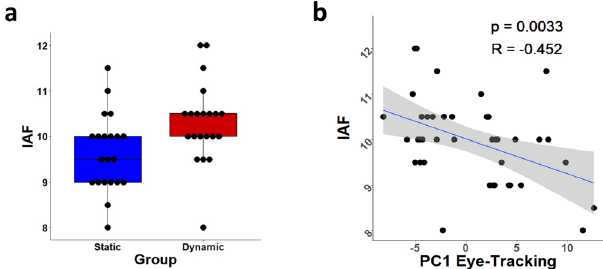
Fig. 2 Individual alpha frequency results. a Individual alpha frequency values by group (static n = 19, median = 9.5 Hz; dynamic n = 21, median = 10.5 Hz). N = 40. b Spearman ’ s rank correlation between PC1 and Individual Alpha Frequency values (with Spearman ’ s r , p -value and 95% CI). N =